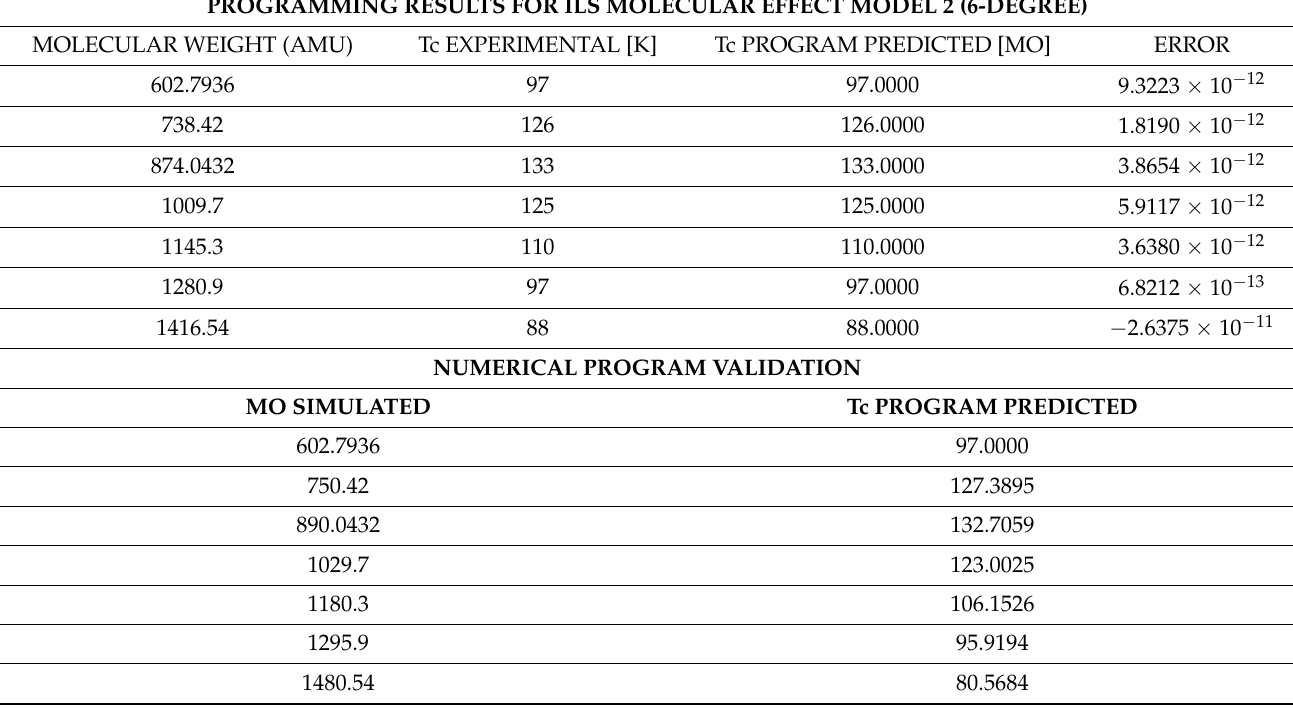
Table 9. Program numerical results for molecular effect model using 6-degree polynomial and approximated equation. Errors are almost null [10 − 12 magnitude order]. Numerical program results for validation simulation give acceptable Tc figures. In this program, MO varied and the corresponding Tc was predicted using the